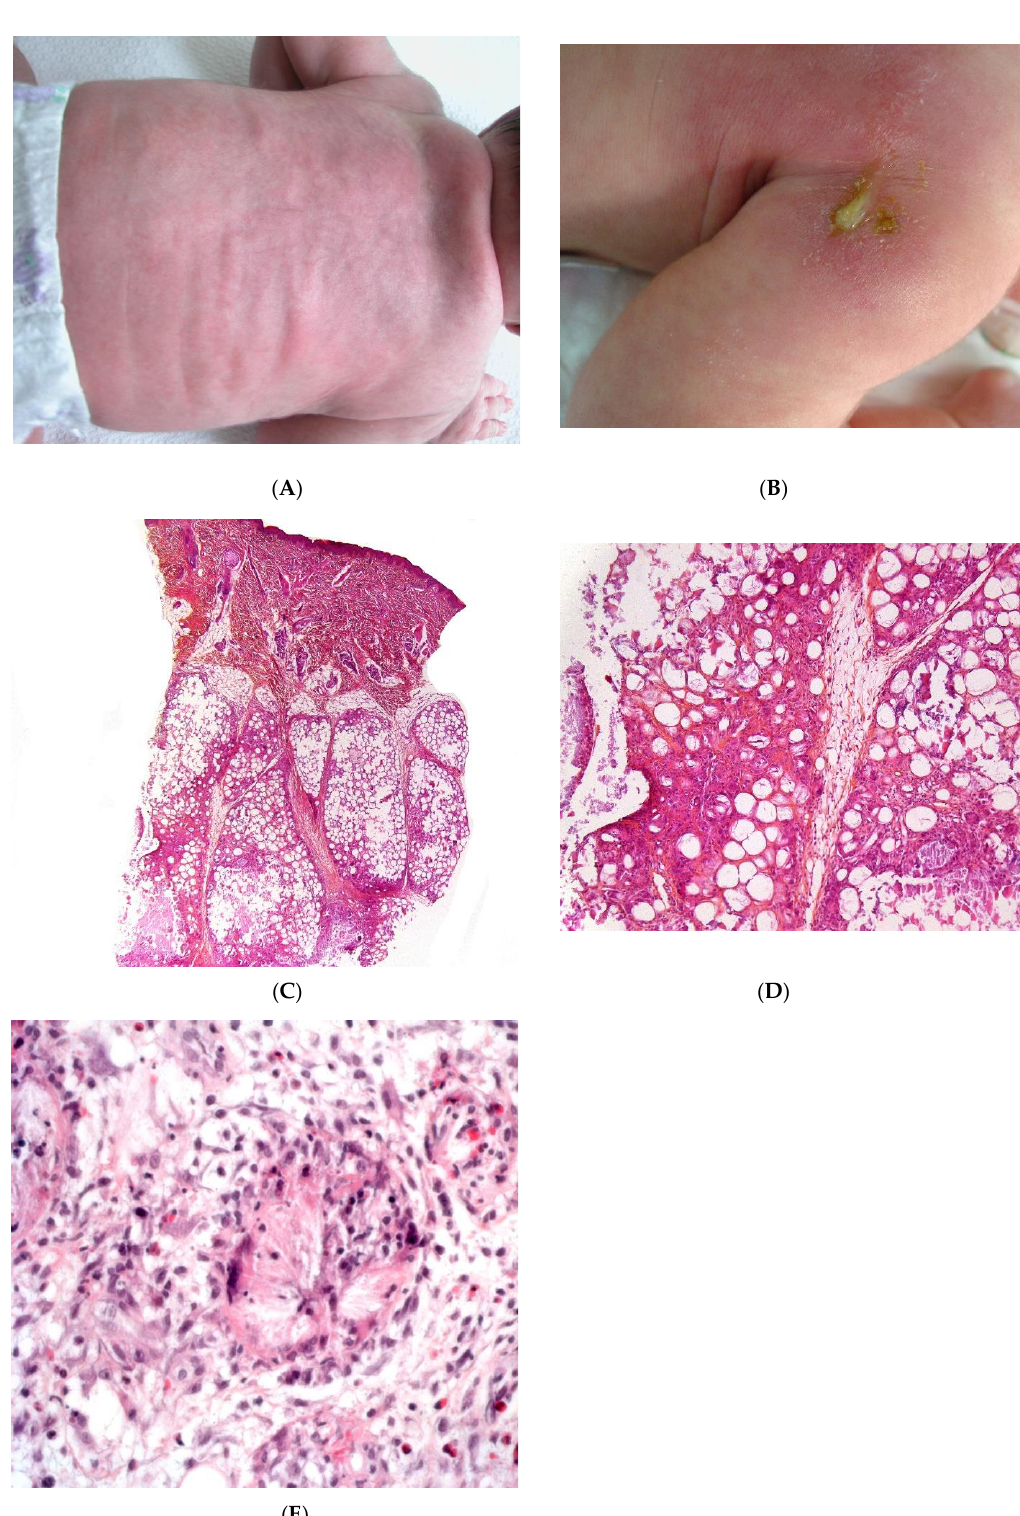
Figure 1. Subcutaneous fat necrosis of the newborn. ( A ) Indurated plaques on the neck and on the back of a newborn. ( B ) Significant purulent material of the shoulder Photo Dermatology Department Hopital Necker Enfants Malades. Paris France. ( C ) Lobular panniculitis without involvement of the dermis (original magnification × 20) ( D ) Many adipocytes are replaced by cells with finely eosinophilic granular cytoplasm that contain narrow needle-shaped clefts (original magnification × 100). ( E ) Needle-shaped crystals in radial fashion surrounded by histiocytes (original magnification ×